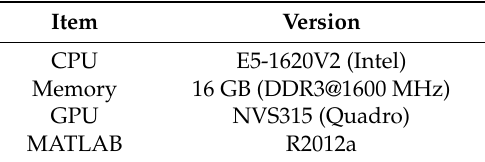
Table 7. The operation environment.